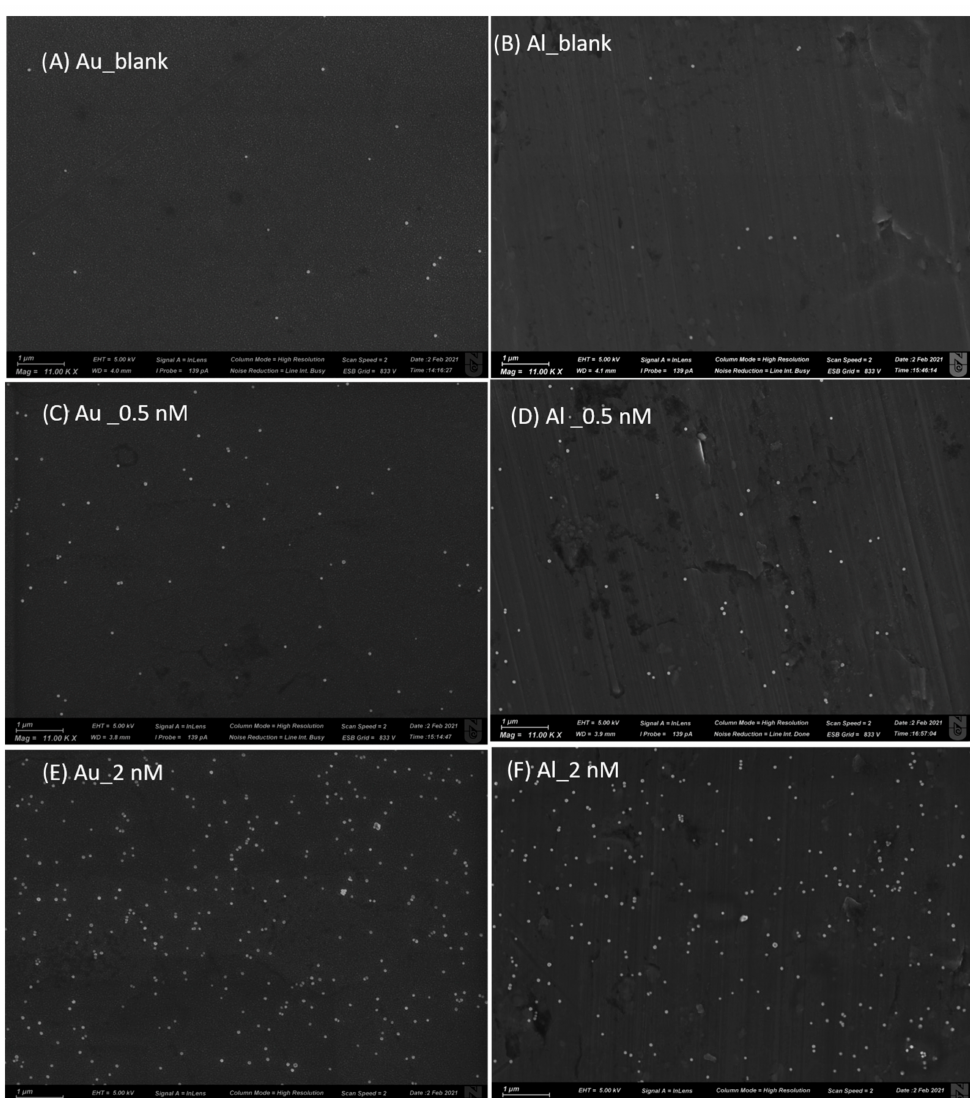
Figure 5. Representative SEM images of sandwich immunoassay on gold and Al tape with human IgG concentrations of 0 (blank), 0.5, and 2